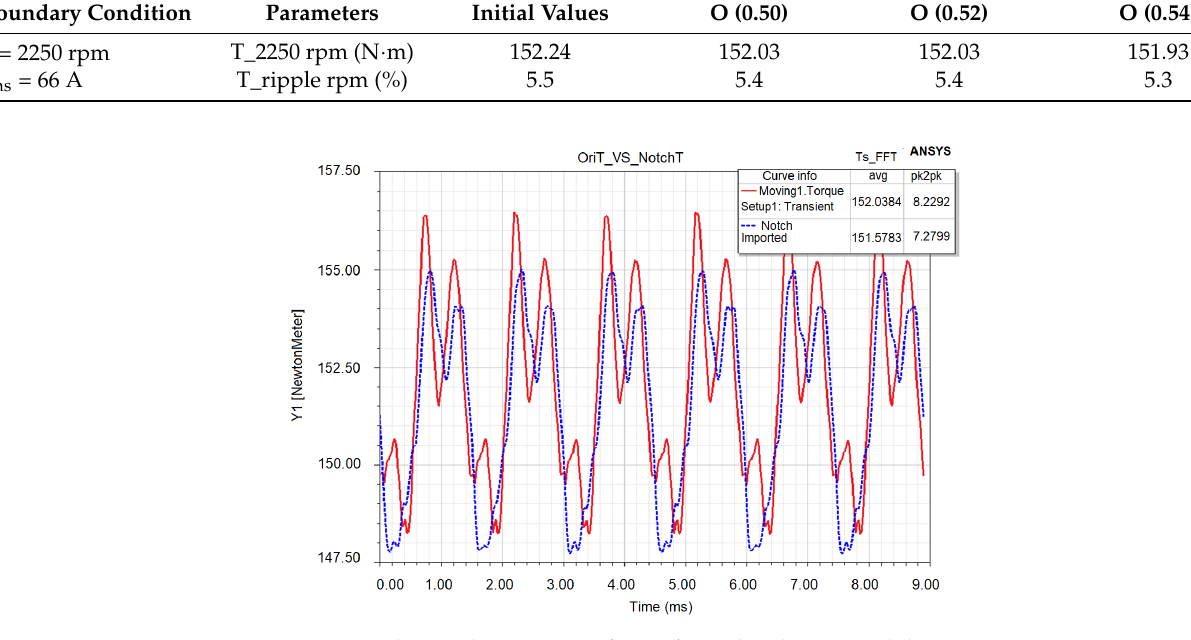
Table 8. Optimization design results of rotor rivet hole diameter.